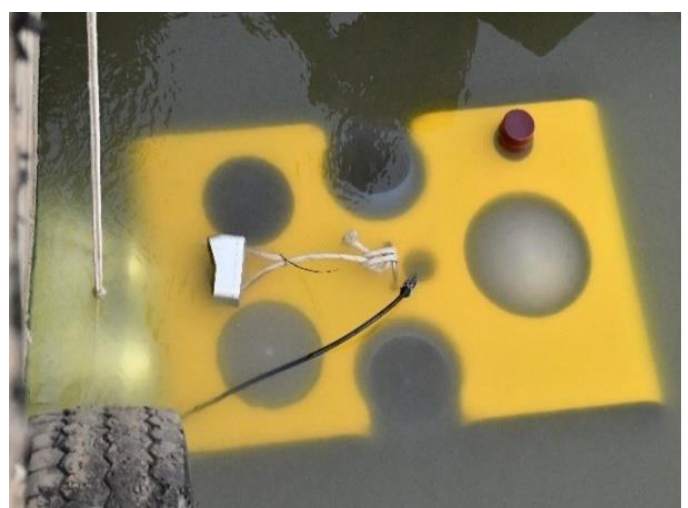
Figure 25. ROV pool test.